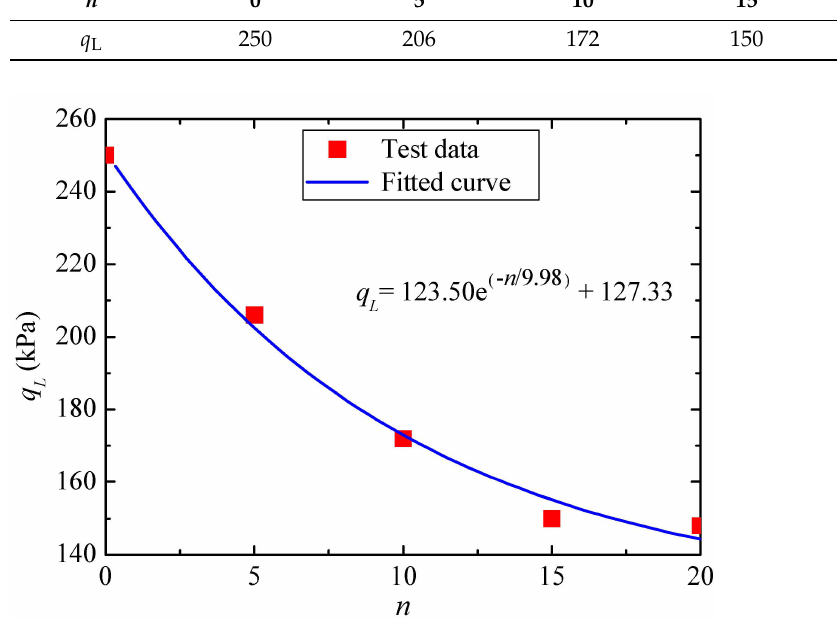
Figure 11. The fitting curve of the long-term strength after different dry-wet